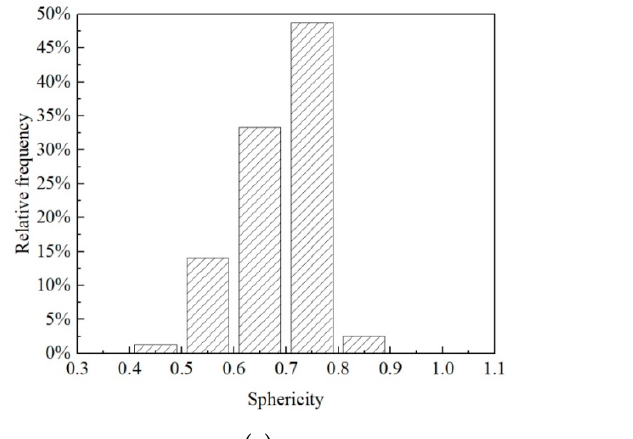
Table 3. Comparison of sphericity distribution of pores.